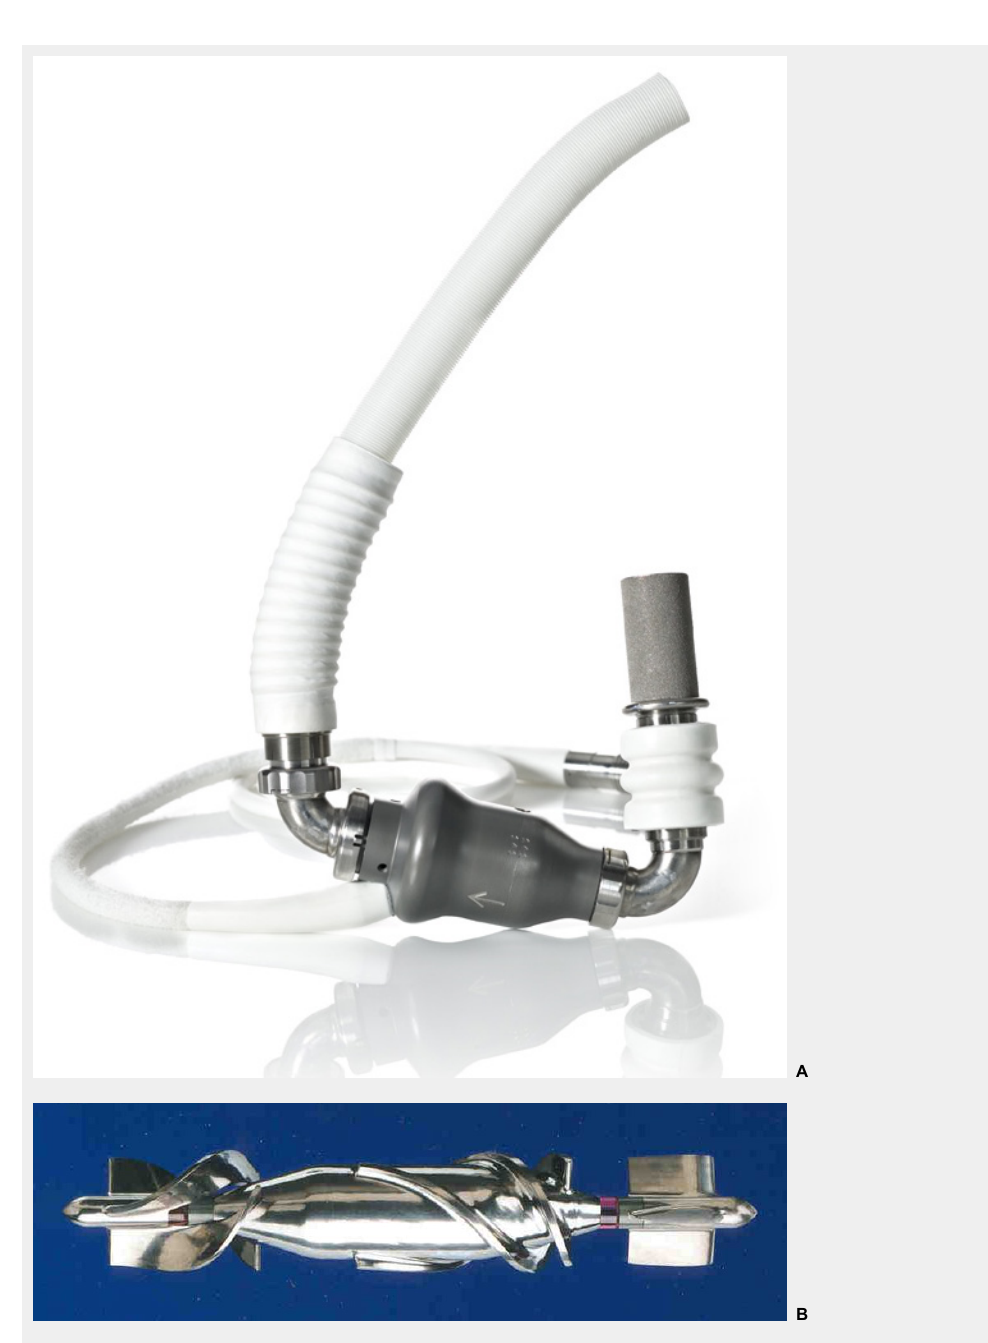
The Heart Mate II left ventricular assist device (reprinted with permission from Thoratec corporation). A: Housing with vascular prothesis to the ascending aorta. B: The impeller which is located within the housing. (© With courtesy by Thoratec